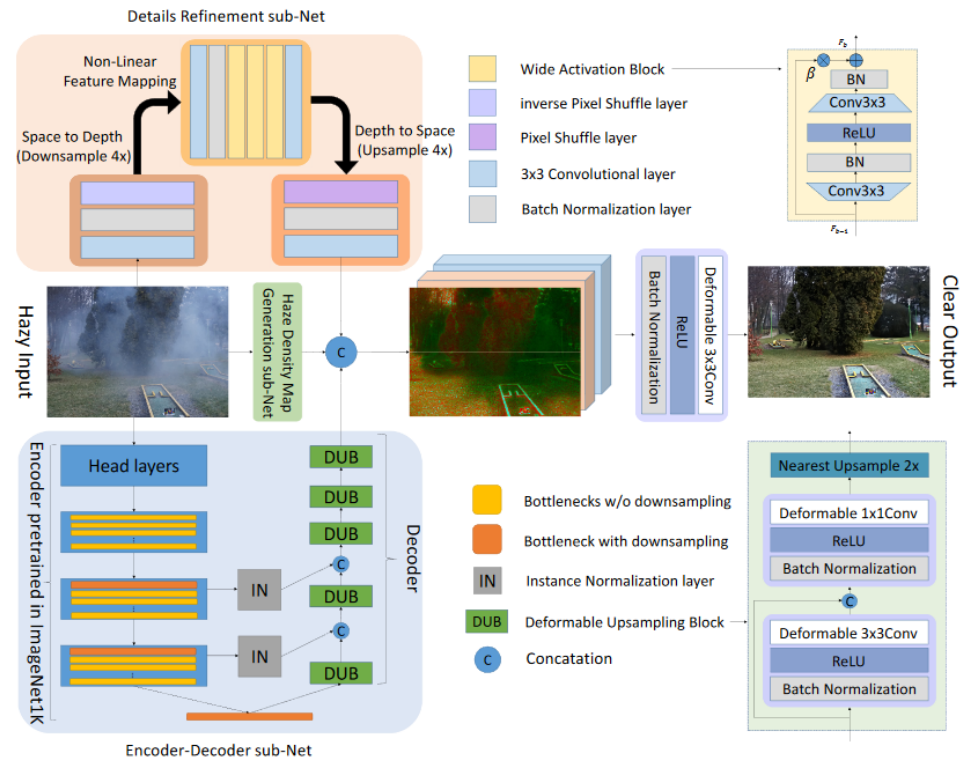
Figure 9. The architecture of Trident Dehazing Network [134]. ⊕ refers to tensor addition and ⊗ to tensor